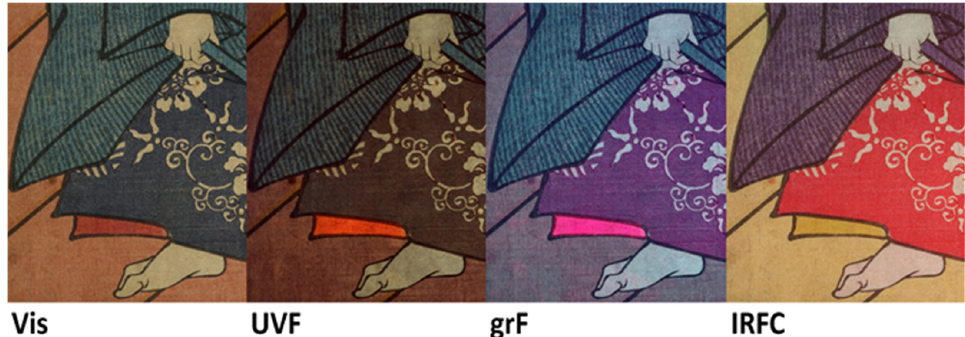
Figure 9. Print 3a, detail in Vis, UVF, grF and IRFC. Blue pigments in the theater costume of the actor show different responses as the band considered changes, allowing a characterization through comparison with spectroscopic data.